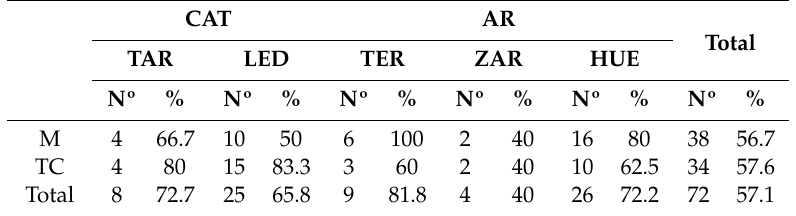
Table 2. Technical data of the questionnaires answered. Breakdown of the answers received in relation to the total number of potential stakeholders (source: authors).